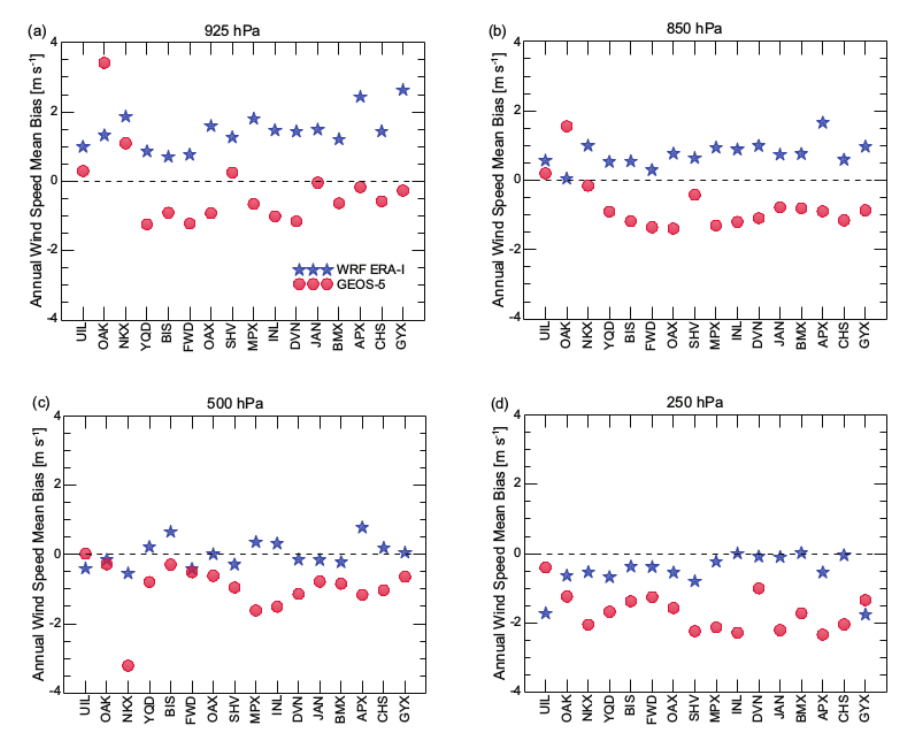
Figure 14. Annual mean wind speed bias [ms − 1 ] at selected rawinsonde sites for 00 UTC soundings in 2010 for WRF initialized with ERA-Interim reanalysis and for GEOS-5 reanalysis at selected mandatory reporting levels: ( a ) 925 hPa, ( b ) 850 hPa, ( c ) 500 hPa, and ( d ) 250